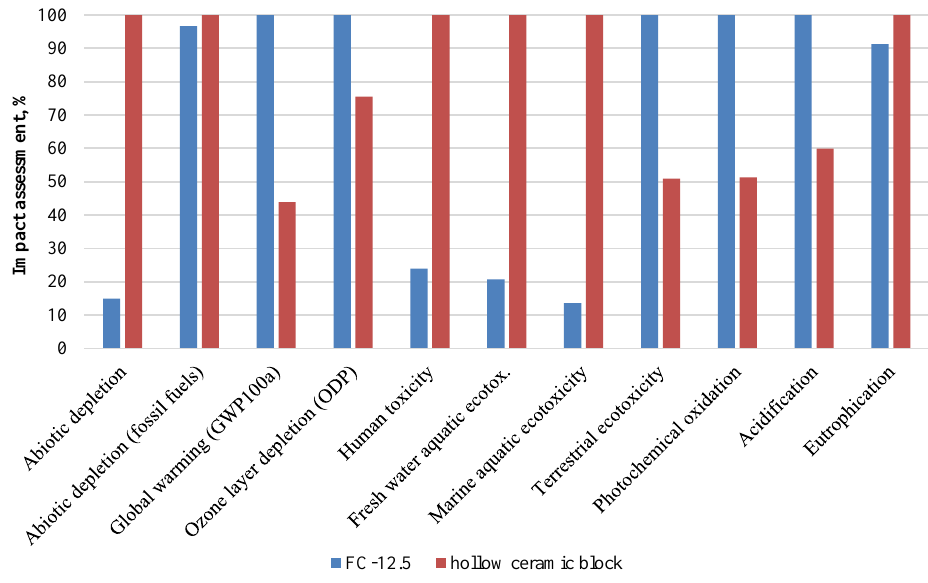
Fig. 4. Foam concrete FC-12.5 impact assessment compared with hollow ceramic block by CML-IA baseline V3.04/EU25. T ABLE 4. C OMPARING FC-12.5 AND H OLLOW C ERAMIC B